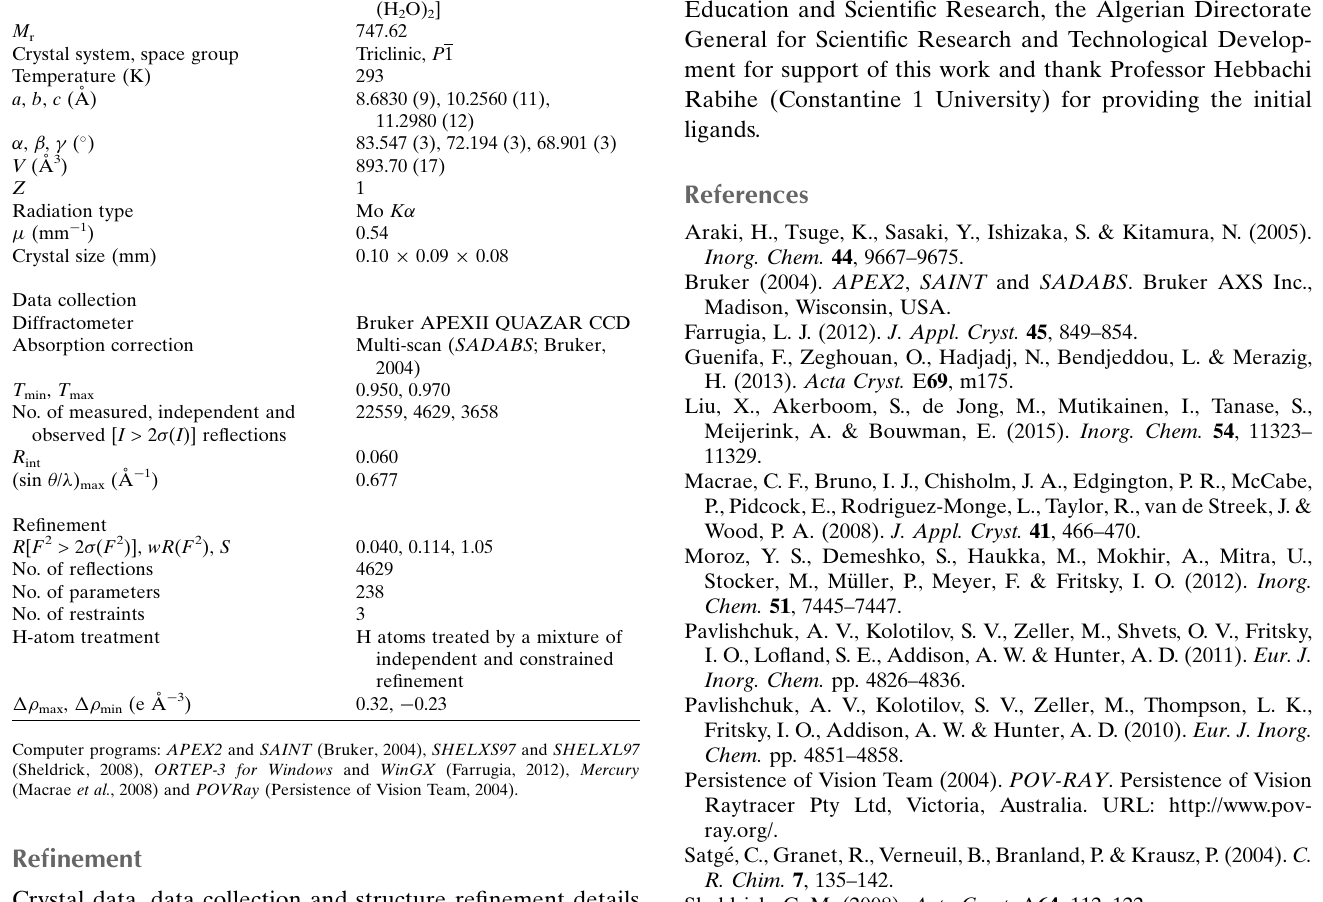
Table 2 Experimental details. Crystal data Chemical